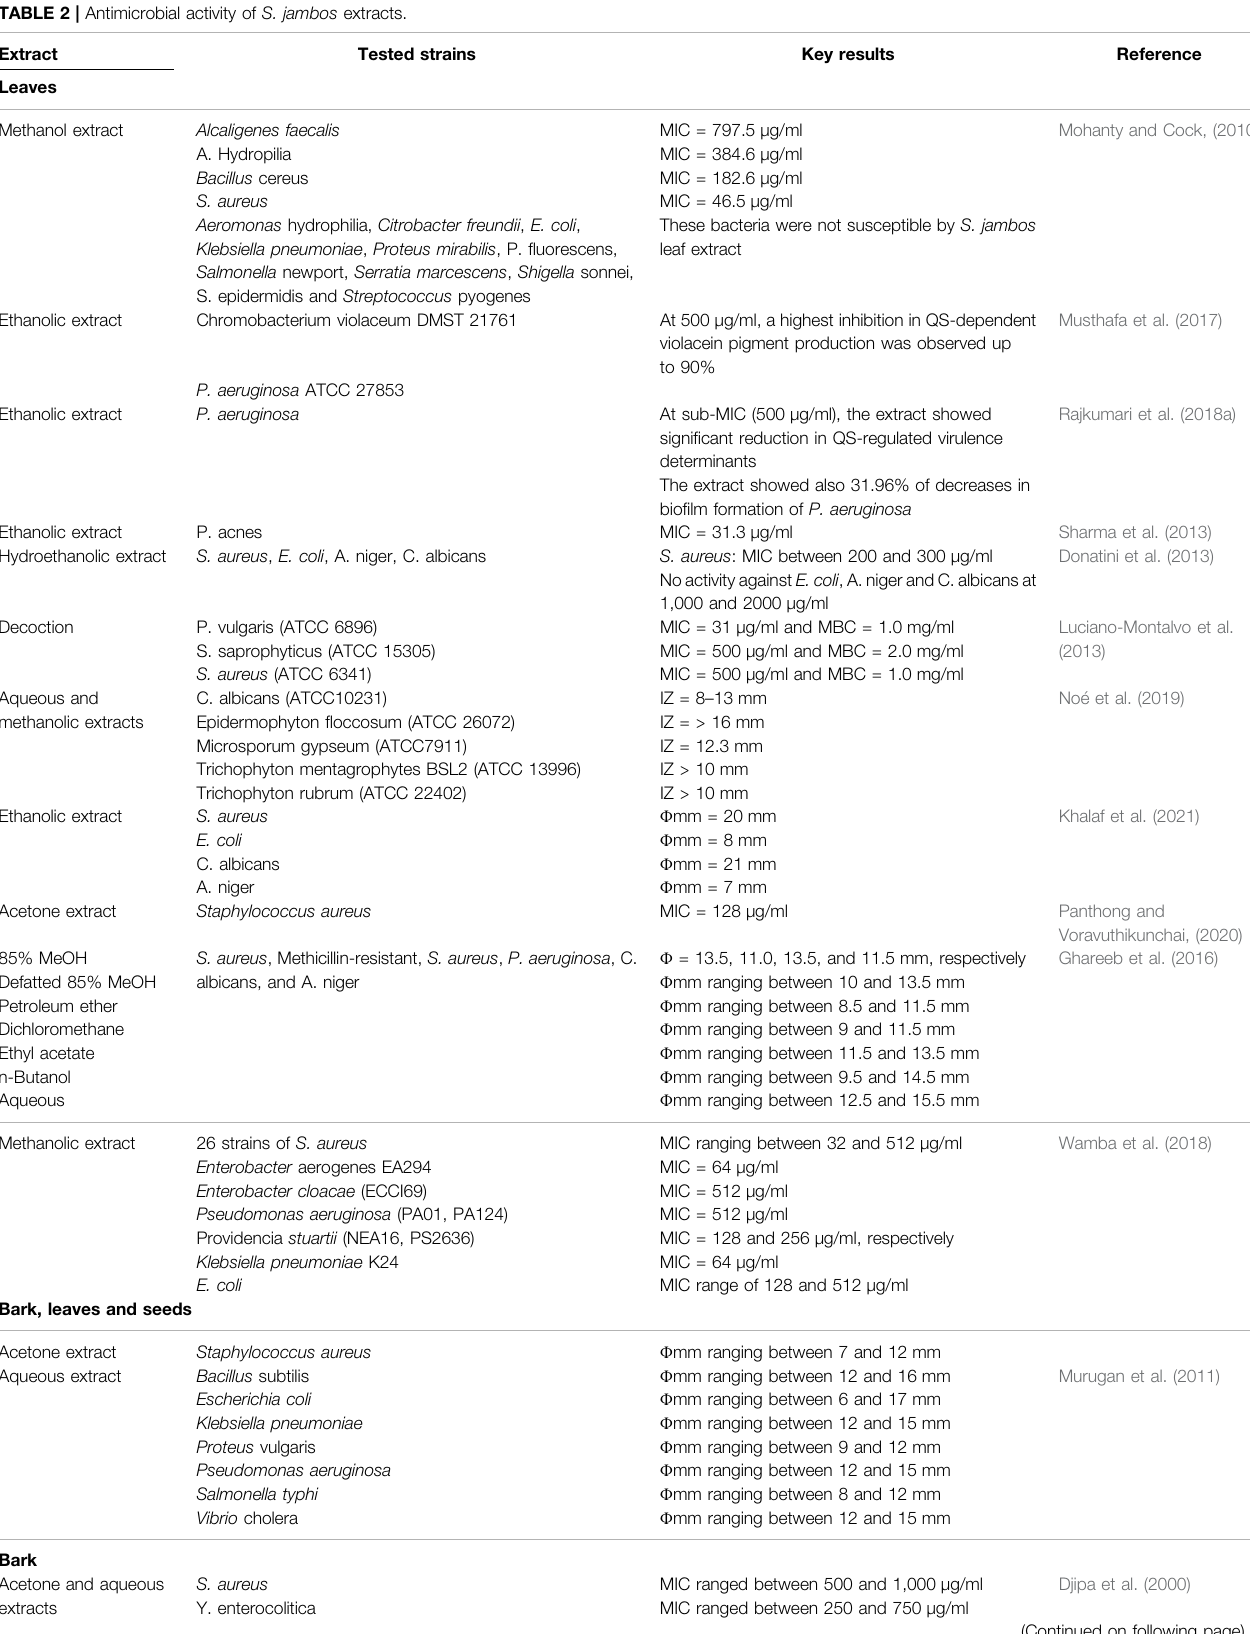
TABLE 2 | Antimicrobial activity of S. jambos extracts. Extract Key results